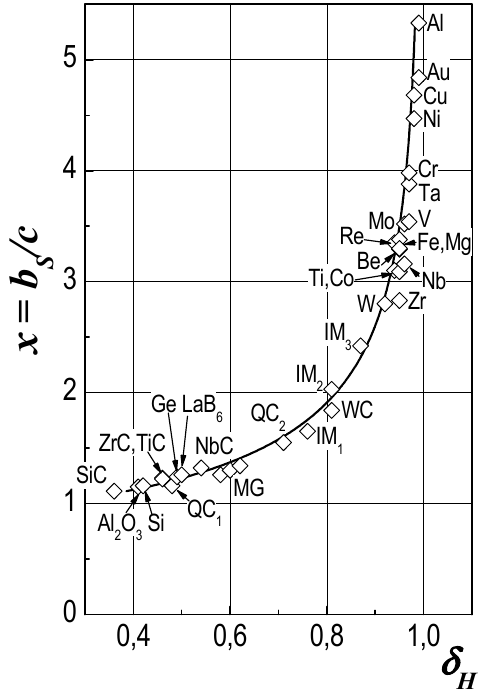
Figure 2. Relation between the plasticity characteristic δ H and the relative size of the elastoplastic deformation zone x . Curve was constructed on the basis of Equation (12) for z = 0.38 and ν S = 0.27. For metals the results of calculation of δ Н by (10) and (12) practically coincide.